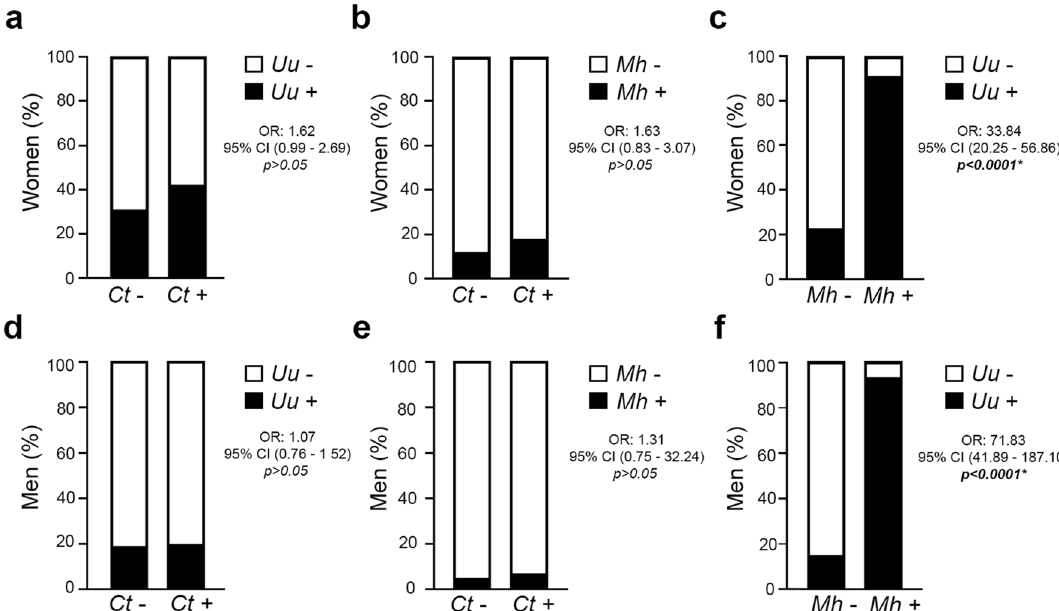
Figure 1. C. trachomatis ( Ct ) , Ureaplasma spp . ( Uu ) and M. hominis ( Mh ) co-infections in patients with couple’s primary infertility. Frequency of positive Uu infection in Ct-infected (Ct+) or Ct-non infected (Ct−) female ( a ) or male ( d ) patients. Frequency of positive Mh infection in Ct-infected (Ct+) or Ct-non infected (Ct−) female ( b ) or male ( e ) patients. Frequency of positive Uu infection in Mh-infected (Mh+) or Mh-non infected (Mh−) female ( c ) or male ( f ) patients. Data are shown as frequency. Chi square test were assessed and odds ratio with 95% confident interval (OR, 95% CI) calculated. A * p < 0.05 was considered statistically Demographic parameters associated to C. trachomatis , Ureaplasma spp. and M. hominis infec‑ tion in patients with couple’s primary infertility. When analyzing the prevalence of infections within the patient population, it was found that C. trachomatis , Ureaplasma spp. and M. hominis infections were sig- nificantly associated with patient sex and age (Table 2). In fact, univariate regression analysis revealed that C. trachomatis infection was more likely to be detected in male than in female patients with an odds ratio of 1.36 (95% CI: 1.02–1.80, p = 0.034) (Table 2). Moreover, a significant association was particularly found between C. trachomatis infection and male patients younger than 25 years (OR: 2.51, 95% CI: 1.40–4.48, p = 0.002, Table 2) indicating that men, and especially those younger than 25 years, are at higher risk of infection than women (Table 2). Multivariate analysis further confirmed these associations (Supplementary Table S1). On the contrary, Ureaplasma spp. and M. hominis infections were associated to female patients, since male patients were less likely at risk of Ureaplasma spp. and M. hominis infection than females with odds ratios of 0.52 (95% CI: 0.46–0.60, p < 0.001, Table 2) and 0.41 (95% CI: 0.33–0.50, p < 0.001, Table 2), respectively. In addition, it was found that Ureaplasma spp. was more prevalent in patients younger than 25 years, either in women or men (OR: 2.27, 95% CI: 1.33–3.89, p = 0.003, and OR: 1.66, 95% CI: 1.04–2.66, p = 0.034, respectively; Table 2). Multivariate analysis further confirmed these data (Supplementary Table S1). These results indicate that C. trachomatis , Ureaplasma spp. and M. hominis urogenital infections are associated with patient sex and age. In fact, patients younger than 25 years at the highest risk of C. trachomatis and Urea- plasma spp. infection. Moreover, our data show that male patients are at higher risk of C. trachomatis infection and, conversely, female patients are at higher risk of Ureaplasma spp. and M. hominis infection. Associations among C. trachomatis , Ureaplasma spp. and M. hominis urogenital infections in patients with couple’s primary infertility. When assessing the co-infection between C. trachomatis and Ureaplasma spp. within the patient population, no significant association was found in either women (OR: 1.62, 95% CI: 0.99–2.69, p > 0.05) or men (OR: 1.07, 95% CI: 0.76–1.52, p > 0.05) (Fig. 1a, d). In fact, a similar preva- lence of Ureaplasma spp. was found in C. trachomatis infected (41.8%, 28/67) and C. trachomatis non-infected (30.7%, 456/1487) female patients (Fig. 1a, Table 3). In addition, a comparable prevalence of Ureaplasma spp. were found in C. trachomatis infected (20.2%, 42/208) and C. trachomatis non-infected (19.1%, 650/3402) male patients (Fig. 1d, Table 3).